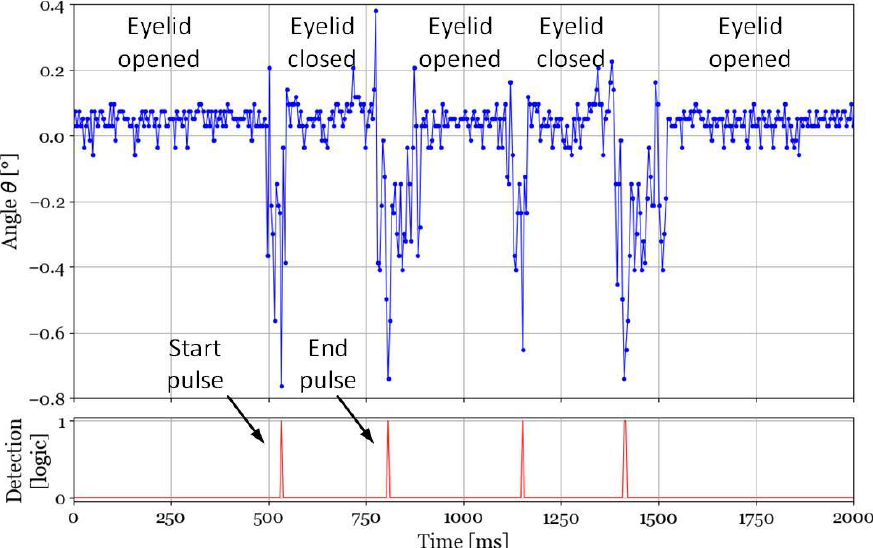
Figure 10. Computed gaze direction versus time. Blink effects on the computation are used to generate blink start and end pulses to establish the blink duration so that the system interprets it as either a reflex or an intentional one.